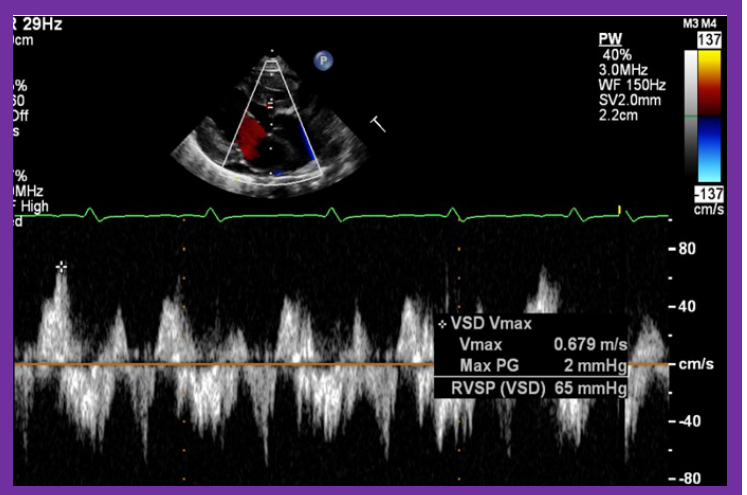
11 of 37 Figure 14. Video frames from a two dimensional echocardiographic and color Doppler study demonstrating ( a ) an atretic tricuspid valve (ATV) between the right atrium (RA) and right ventricle (RV), and blood flow from the left atrium (LA) into the left ventricle (LV) across the mitral valve. The RV (arrow) is very small and hypoplastic. ( b ) LV and RV with a large ventricular septal defect (VSD) below the truncus arteriosus (TA). Turbulent flow across the truncal valve suggests truncal valve stenosis. ( c ) The origin of the pulmonary artery (PA) from the TA by color flow (arrow), and ( d ) the division into right (RPA) and left (LPA) pulmonary arteries from the PA in a short-axis view. TV, truncal valve leaflets. Reproduced from Rao PS, et al. Am Heart J 1991;122:829-835 [31]. Further subdivision (Figure 2, bottom) into subtypes a (pulmonary atresia), b (pul- monary stenosis or hypoplasia), and c (normal valve and pulmonary arteries) is under- taken by echo-Doppler examination of the pulmonary valve and PAs, irrespective of the types, I, II, III or IV. Then, the ventricular septum is evaluated; the ventricular septum is intact in most Type Ia cases. In children with Type I (normally related great arteries), the VSD supplies the pulmonary blood flow (Figure 10) while in patients with Type II (transposition of the great arteries) the VSD allows the blood to flow into the systemic circuit (Figure 11; Figure 12). In Type I patients, the VSD is demonstrated by 2D (Figure 10A), and the left to right shunt across it by color (Figure 10B), pulsed and CW (Figure 10C) Doppler signals. The interrogation of the RV outflow tract and PA region should be performed; recording the peak Doppler flow velocity across the RV outflow tract and the pulmonary valve is helpful in identifying obstruction across these sites. The Doppler data from the VSD and RV out- flow tract are also helpful in the estimating of PA pressures. In Type I babies, the 2D size